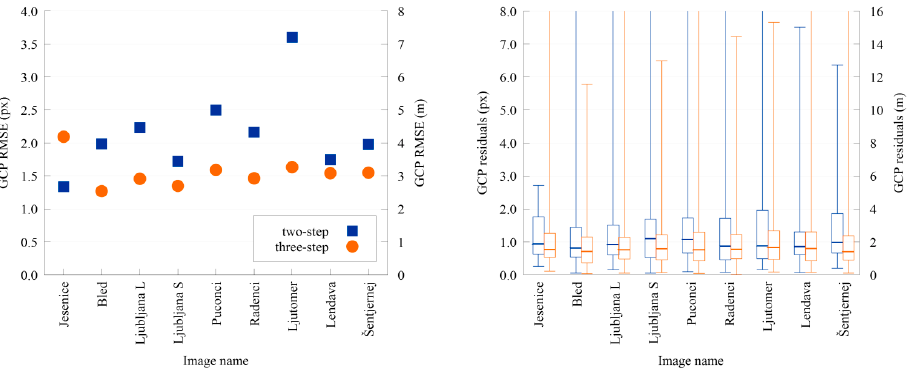
Figure 10. RMSE in pixels/meters at extracted GCPs per image ( left ) and boxplots of corresponding GCP residuals ( right ) for nine WorldView-2 images at levels 1B and 2A. The results from the original two-step algorithm consisting of coarse matching and fine positioning (squares) and the improved three-step algorithm with the added super-fine positioning (circles) were